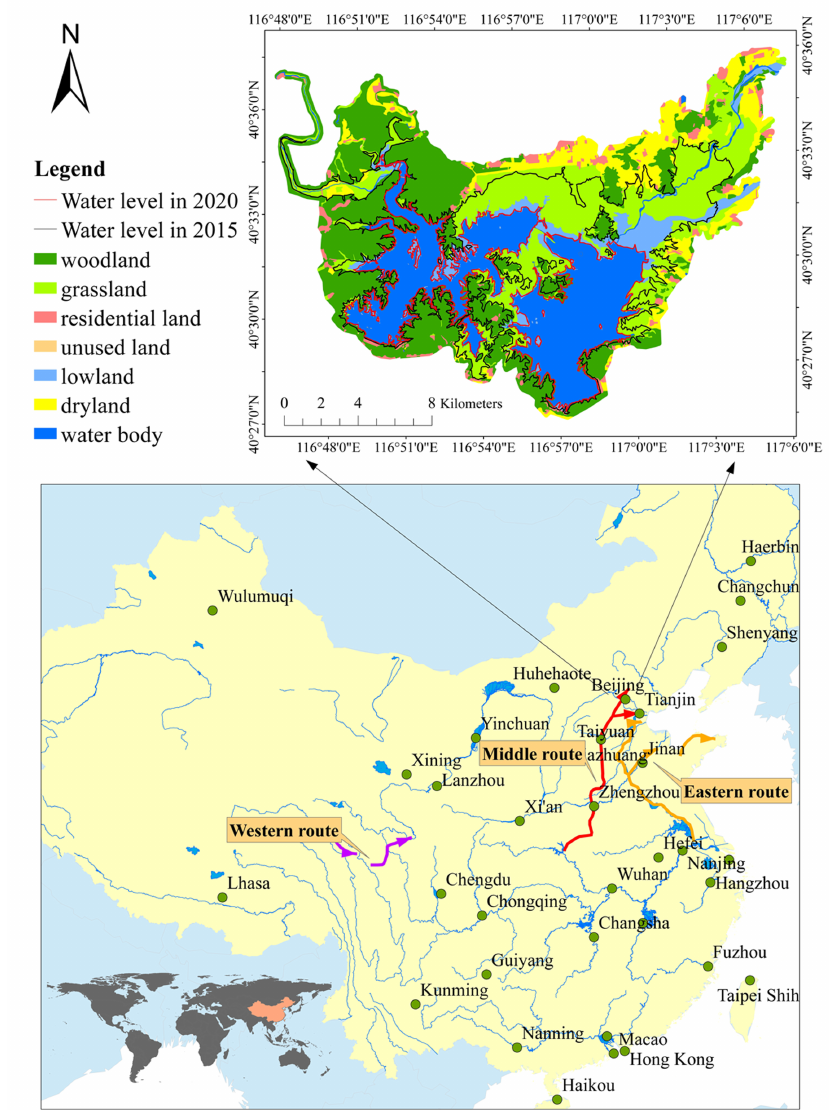
Figure 1. Schema of the South-to-North Water Transfer Project in China and land use information for the terminal Miyun Reservoir of the middle